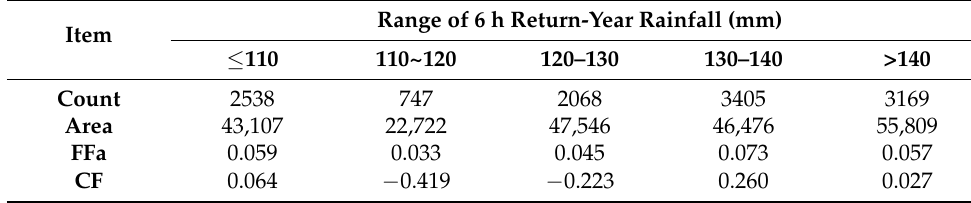
Table 10. CF Values of 6 Hour Return-Year Rainfall.